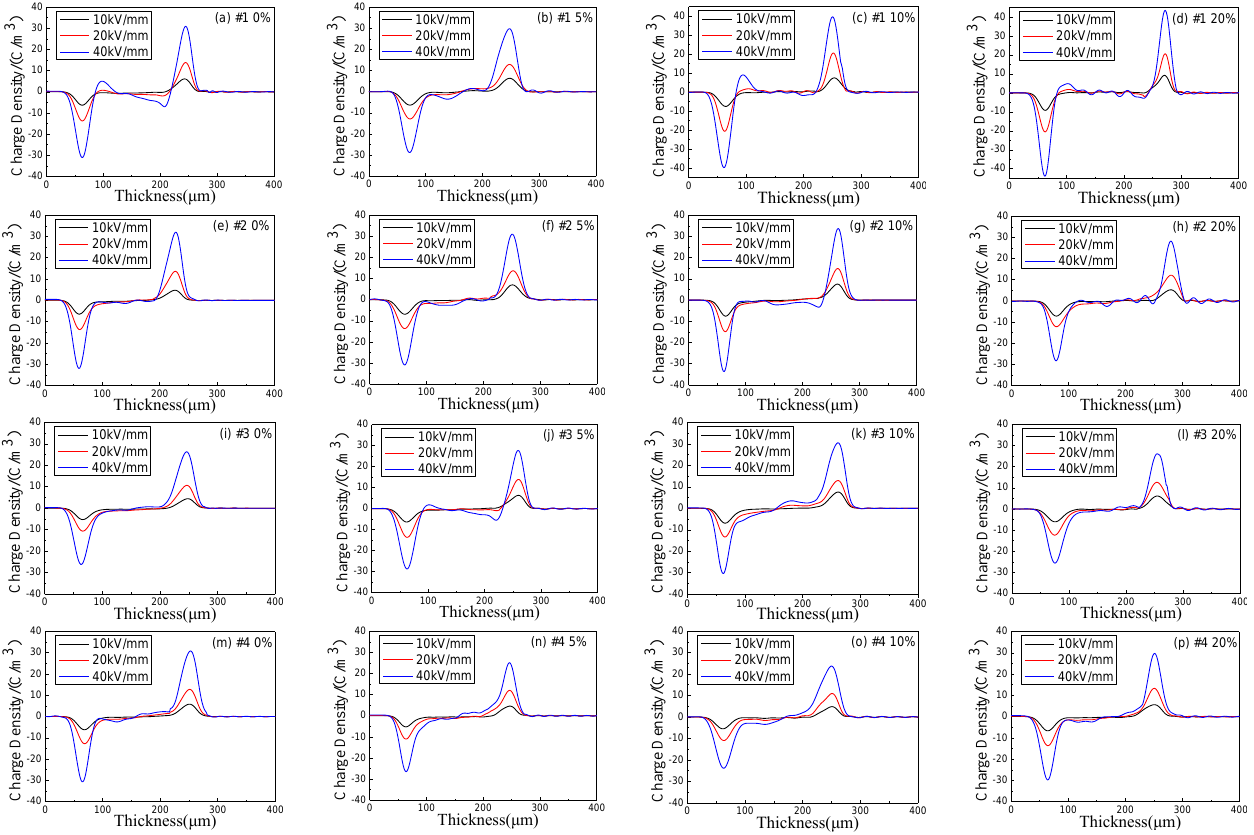
Figure 7. Space charge distribution of composites under polarization electric field after 30 min. (( a – d ) are the space charge characteristic curves of sample 1 under the tensile ratio of 0%, 5%, 10% and 20% respectively; ( e – h ) are the space charge characteristic curves of sample 2 under the tensile ratio of 0%, 5%, 10% and 20% respectively; ( i – l ) are the space charge characteristic curves of sample 3 under the tensile ratio of 0%, 5%, 10% and 20% respectively; ( m – p ) are the space charge characteristic curves of sample 4 under the tensile ratio of 0%, 5%, 10% and 20%